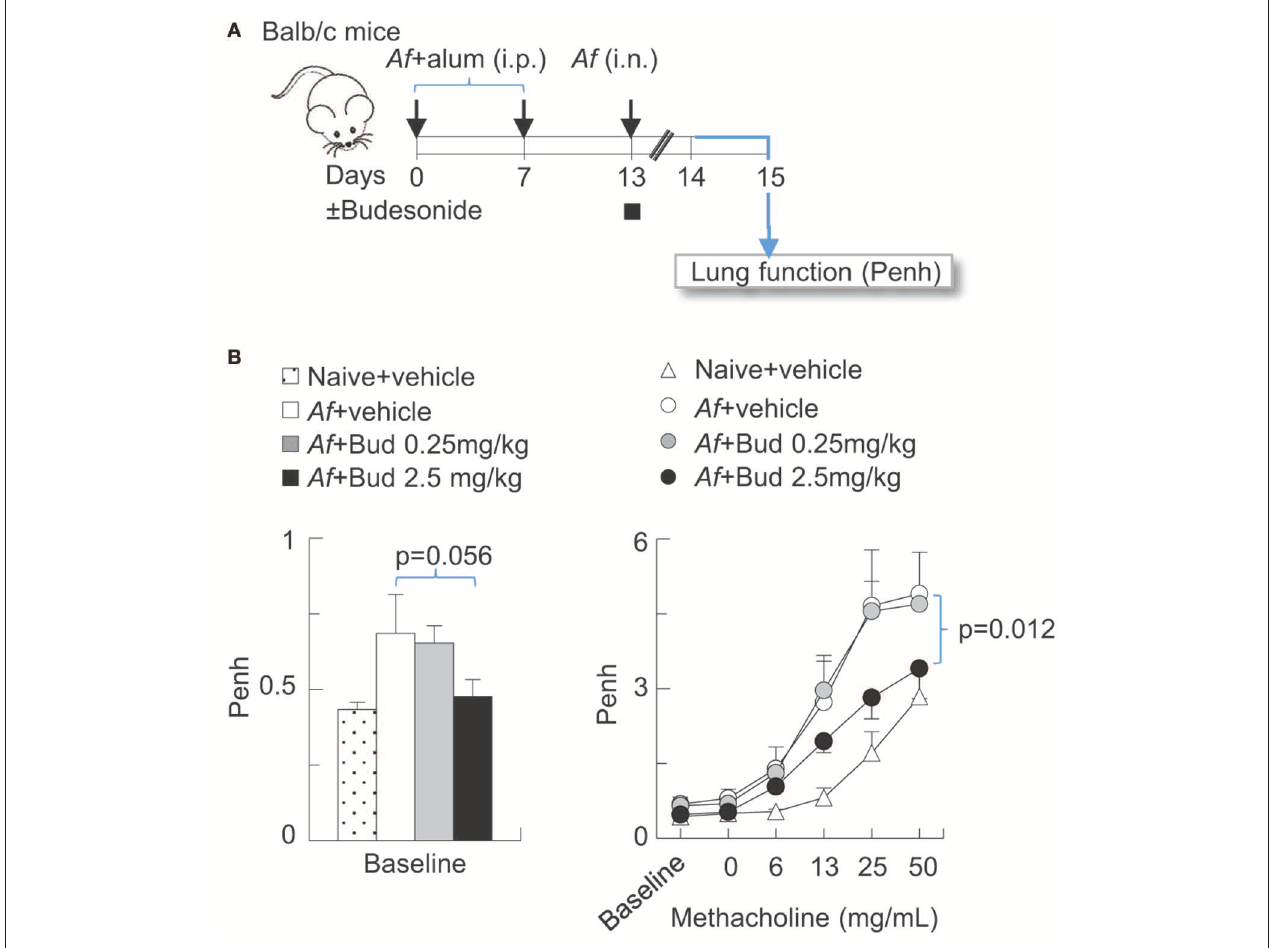
FIGURE 1 | Budesonide inhibited airway hyperreactivity induced by Af sensitization and challenge in Balb/c mice, in a dose-dependent manner. (A) Balb/c mice were sensitized to 20 µ g Aspergillus fumigatus ( Af ), with alum (i.p.) on days 0 and 7. On day 13, mice were challenged with 25 µ g Af (i.n.) and administered 0 (DMSO vehicle only), 0.25 or 2.5 mg/kg budesonide. 48h post- Af challenge mice were studied. (B) Lung function (enhanced pause, Penh) was measured by the Buxco ® system. Baseline measurements represent data collected over a 10min period (left panel). Methacholine dose response was established to increasing concentrations of nebulized methacholine. Mean ± SEM of n = 4–18 (left panel: Dunett’s multiple comparison; right panel: Two-way ANOVA with Tukey’s multiple